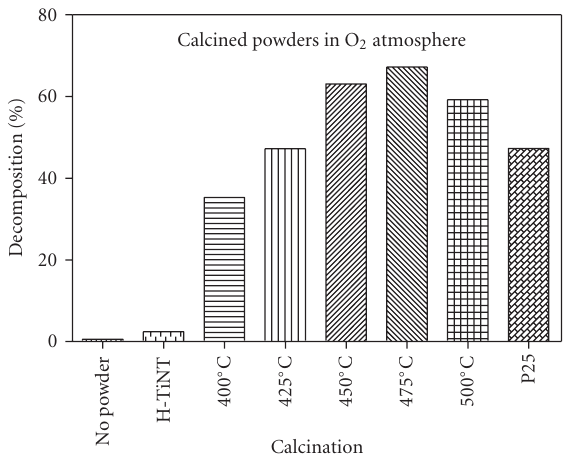
Figure 3: Photocatalytic 4-CP decomposition results of the pow- ders calcined at various temperatures for 30min in O 2 atmosphere and of H-TiNT, comparing with that of P25